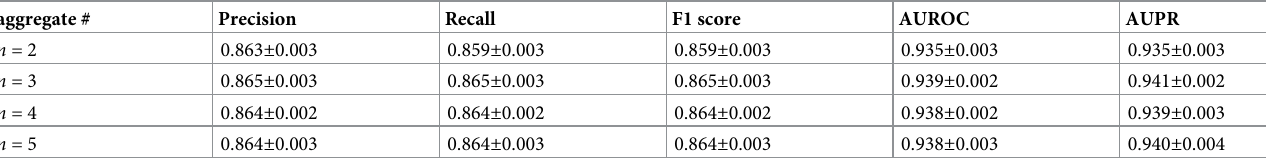
Table 4. Comparing different aggregation numbers in the GCNMLP.